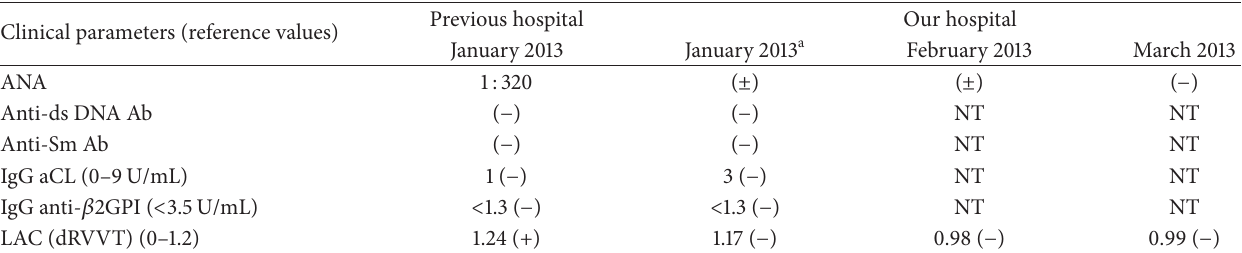
Table 1: Clinical course and laboratory